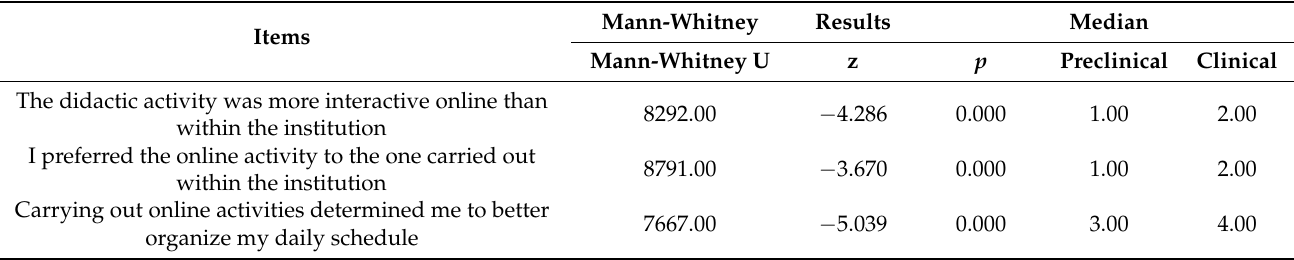
Table 7. Opinions of dental students regarding online activity. Differences by preclinical versus clinical years 1